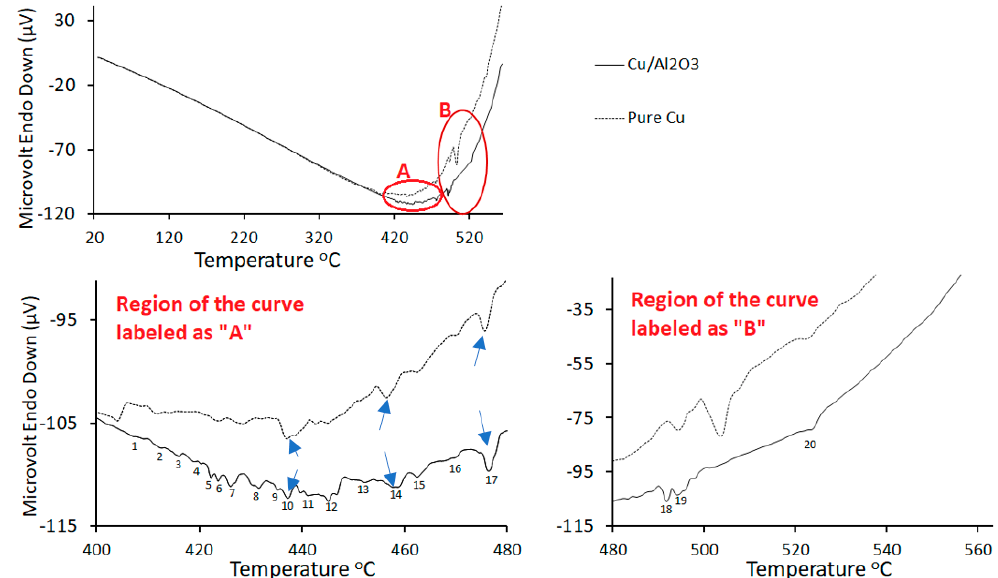
Figure 3. Thermogravimetric analytical curves of the Mg/Cu/Al and Al/Cu-Al 2 O 3 /Mg joints. The analysis was performed in nitrogen having a flow rate of 40 mL/min and a heating rate of 10 °C/min. Microstructural analysis of the joint zone (see Figure 4A) shows the presence of a eutectic microstructure at the Mg-side of the interface which confirms the formation of the eutectic reaction during bonding. When Cu/Al 2 O 3 as used as the interlayer a larger eutectic microstructure was observed at the interface as shown in Figure 4C. Extensive melting was also observed at the grain boundaries within the Mg sample as shown in Figure 5 when both pure-Cu and Cu/Al 2 O 3 interlayer were used.